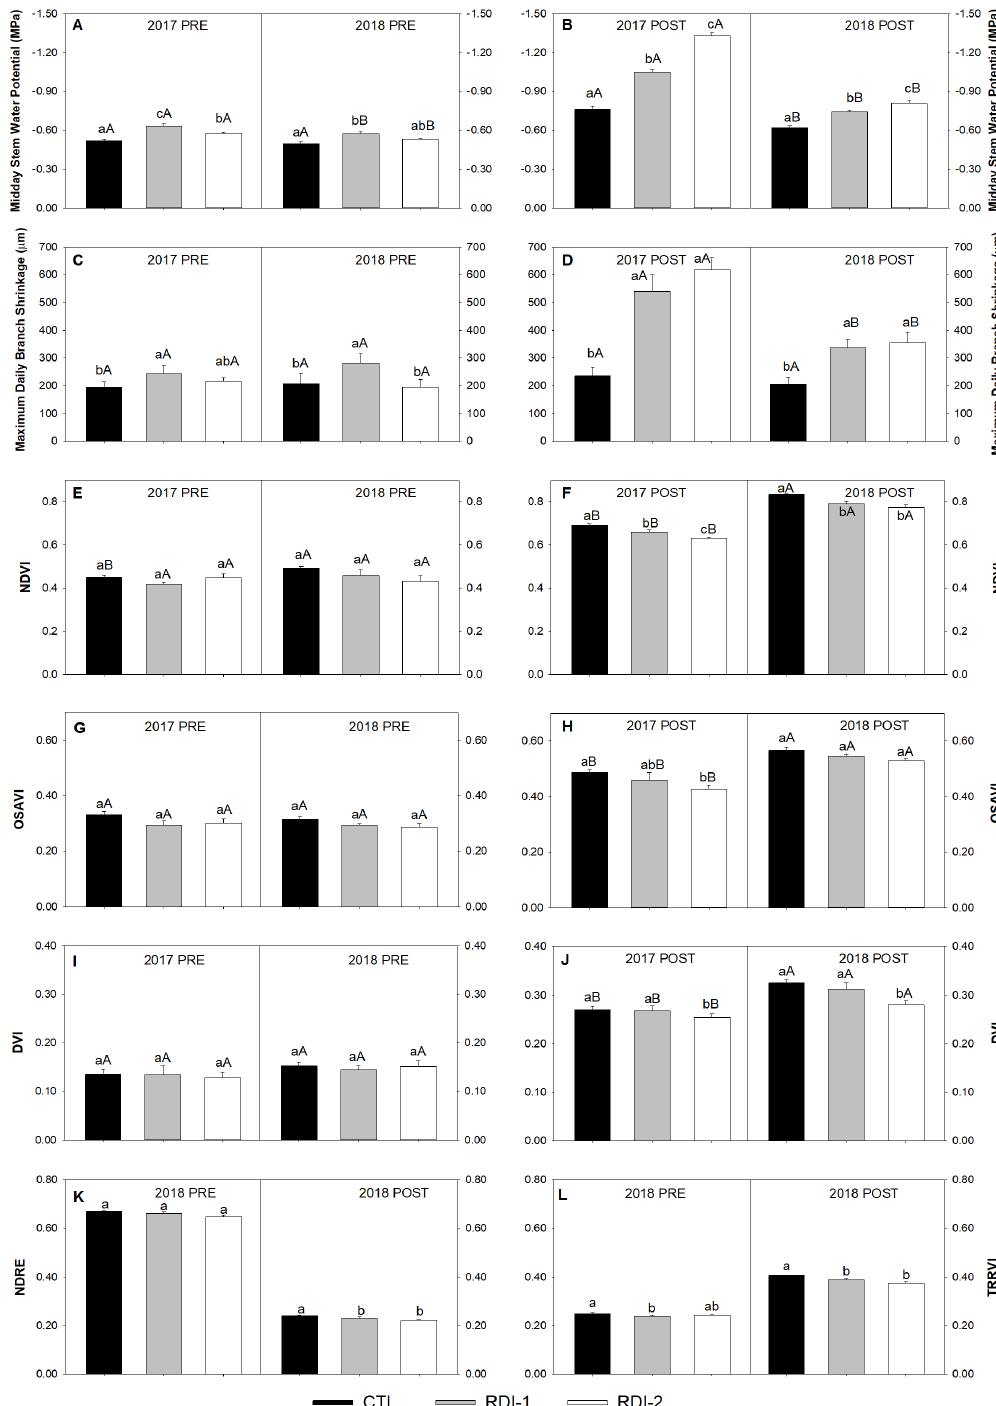
Figure 3. Mean values ± standard error of midday stem water potential (A,B), maximum daily branch shrinkage (C,D), normalized difference vegetation index (NDVI) (E,F), optimized soil adjusted vegetation (OSAVI) (G,H), difference vegetation index (DVI) (I,J), normalized difference red edge (NDRE) (K), and transformed red range vegetation index (TRRVI) (L) in preharvest (PRE) and postharvest (POST) flights for control (CTL)and regulated deficit irrigation treatments (RDI-1 and RDI-2). Lowercase letters indicate the statistical significance between irrigation treatments within the same year and capital letter indicate the statistical significance between years within the same treatment at p ≤ 0.05 ( n =